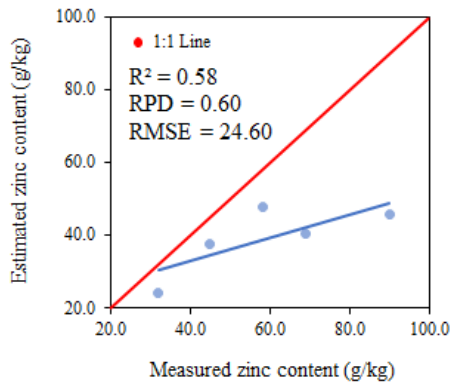
Figure 11. Relationship between the measured and estimated levels of zinc at phenological stage R6.